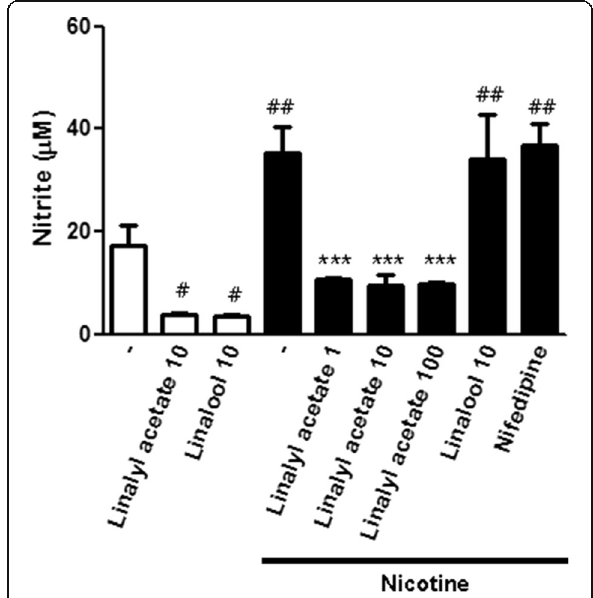
Fig. 4 Effect of linalyl acetate and linalool on serum nitrite concentration in nicotine-untreated and treated rats. The concentra- tions of nitrite were measured using nitrite assay. Data represent mean values±S.E.M. ( n =5 – 6 per group). ## p <0.01, # p <0.05 compared with the control group; *** p <0.001 compared with nicotine